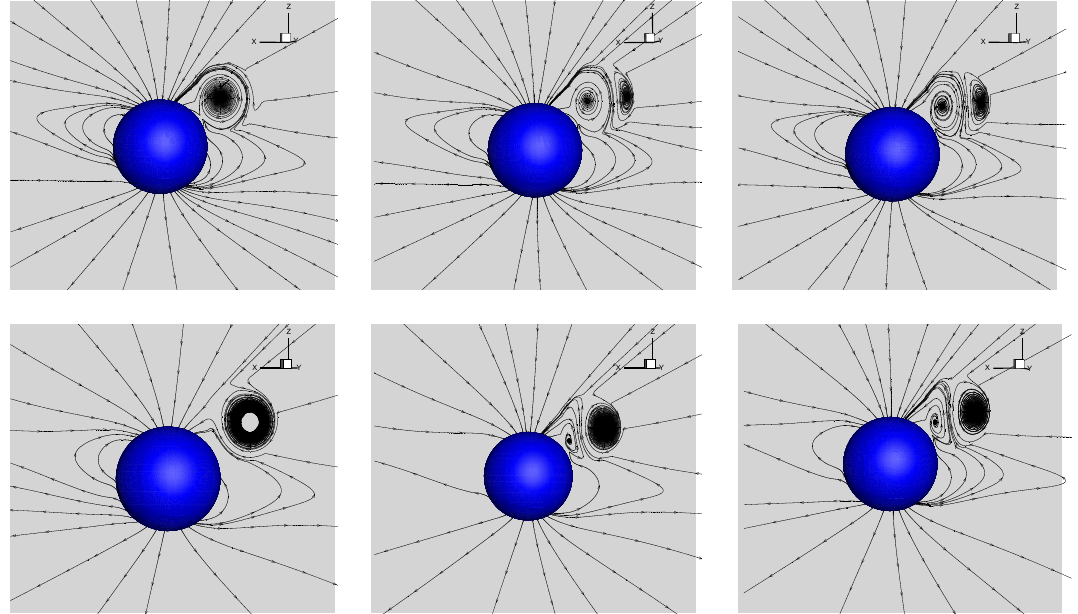
Fig. 18. The projected magnetic fi eld lines in the x – z meridional plane with different inclination angle of CMEs. The top row is for case 1 (left), case 2 (middle), case 3 (right), and the bottom is for case 4 (left), case 5 (middle), case 6